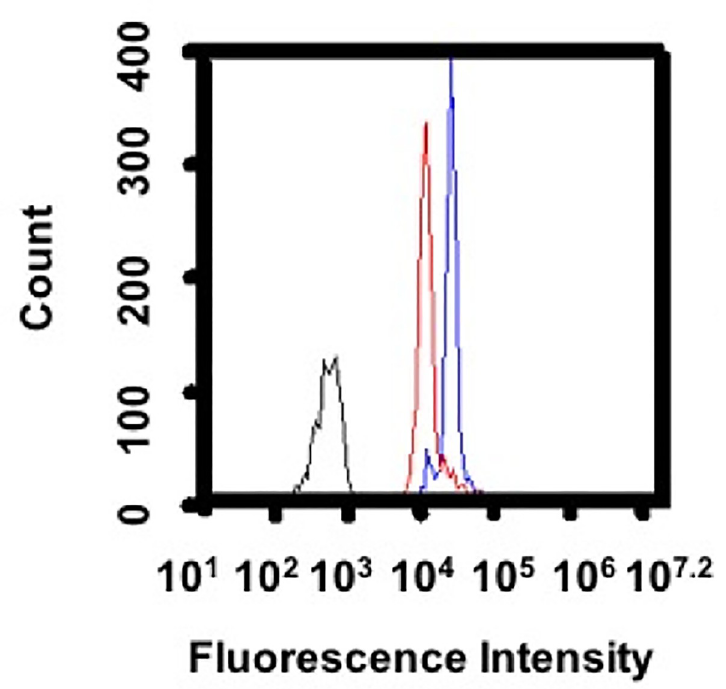
Fig 5. Effect on eGFP structure when adsorbed to shaped particles. Spherical (blue) or rod shaped (red) particles were incubated with eGFP for 15 minutes. Plain particles (black) indicate particle autofluorescence. Representative traces are shown, which were consistent across three independent batches of eGFP coated